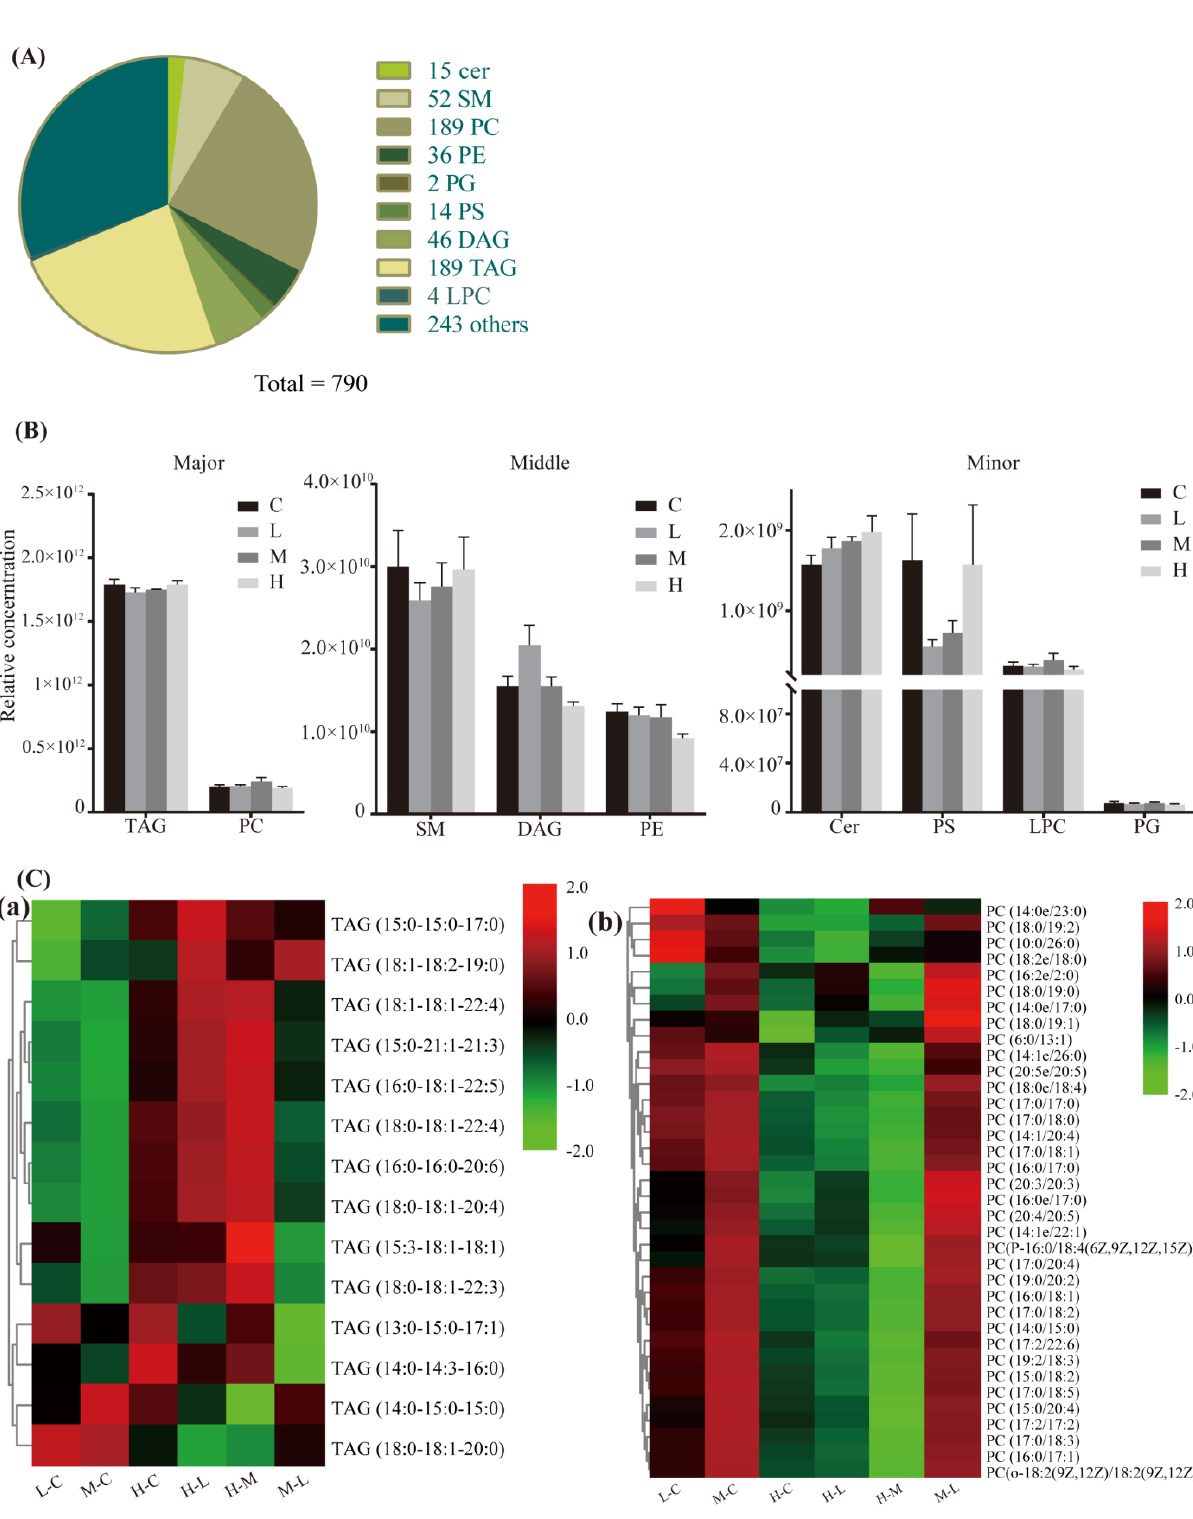
Figure 4. General analysis of dorsal subcutaneous adipose tissue (DSAT) lipidomics profiles in Tan lambs. ( A ) Overall distribution of major lipid classes DSAT, n ≥ 5 per group. ( B ) Total relative content of every lipid class. ( C ) Heatmap generated from two major lipids of triacylglycerol (TAGs) (a) and phosphatidylcholines (PCs) (b) using hierarchical clustering (Pearson-distance-clustering algorithm) in TBtools. C, control; L, 10% Agriophyllum squarrosum diet; M, 20% A. squarrosum diet; H, 30% A. squarrosum diet.